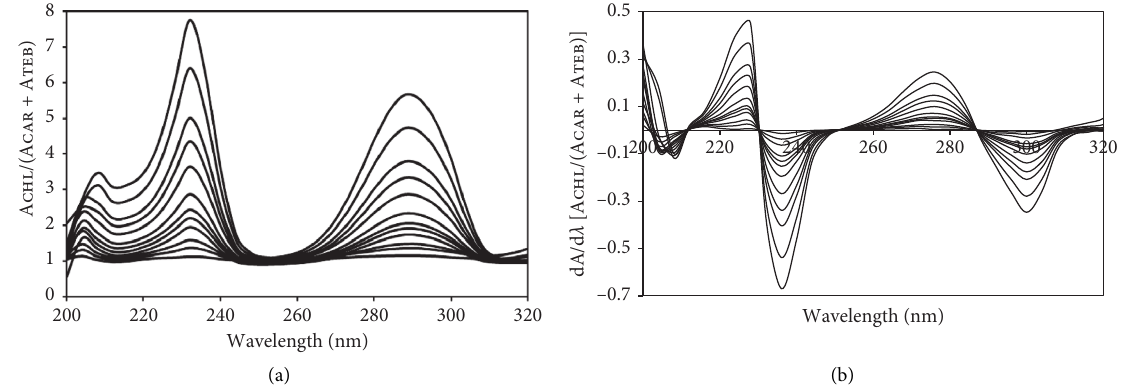
Figure 7: (a) Ratio spectra and (b) first derivative of the ratio spectra of CHL (1, 3, 5, 8, 10, 12, 15, 20, 25, 30, 40, and 50 μ g/mL) using 5 μ g/mL CAR +5 μ g/mL TEB as a double divisor in methanol at Δ λ � 4.